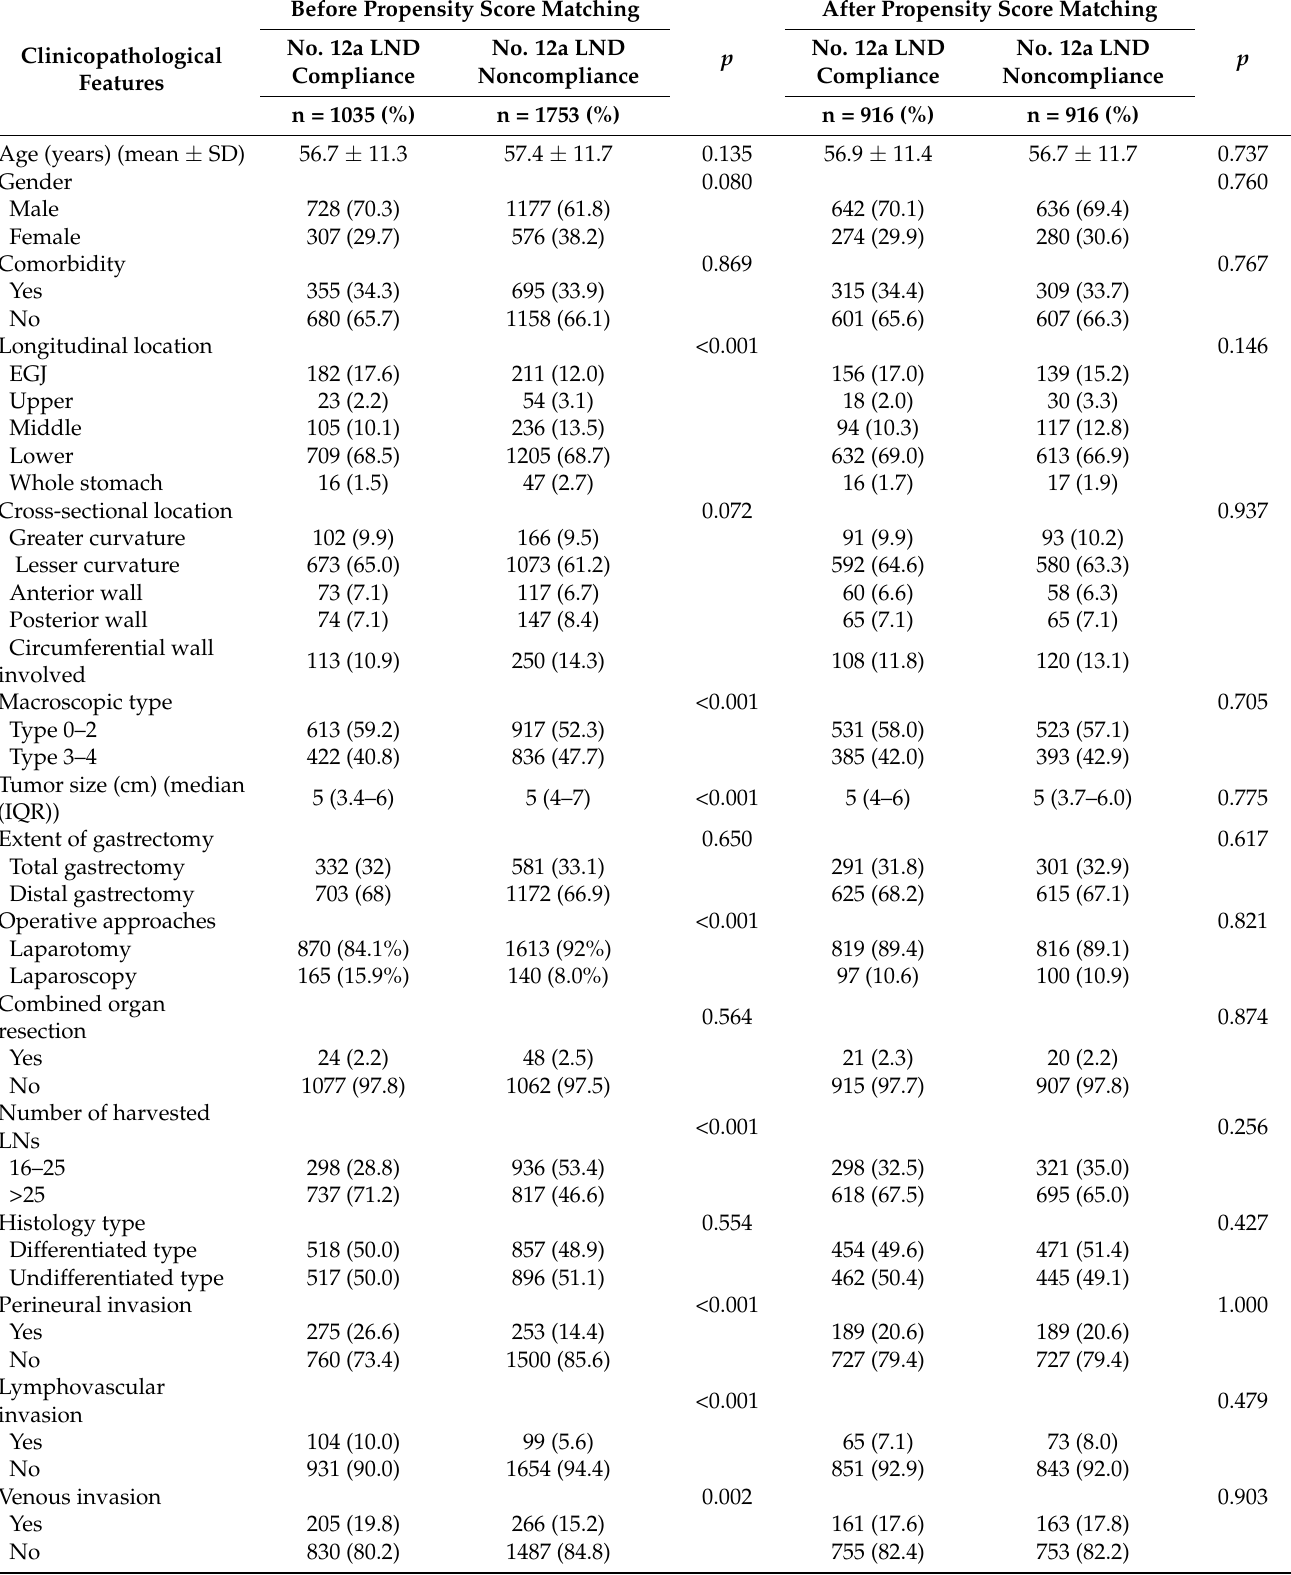
Table 2. Details of clinicopathological features before and after 1:1